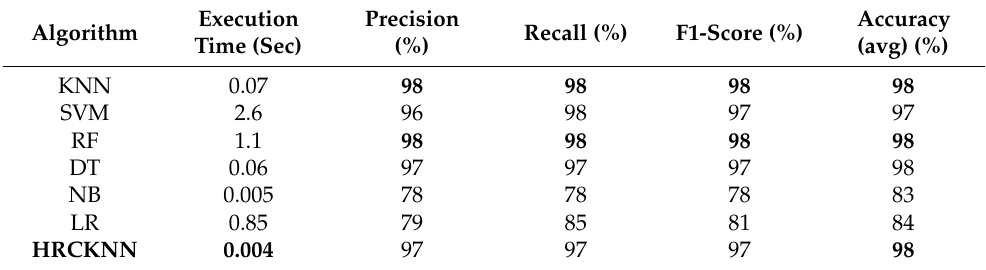
Table 4. Performance Comparison of Machine Learning Algorithms with HRCKNN.